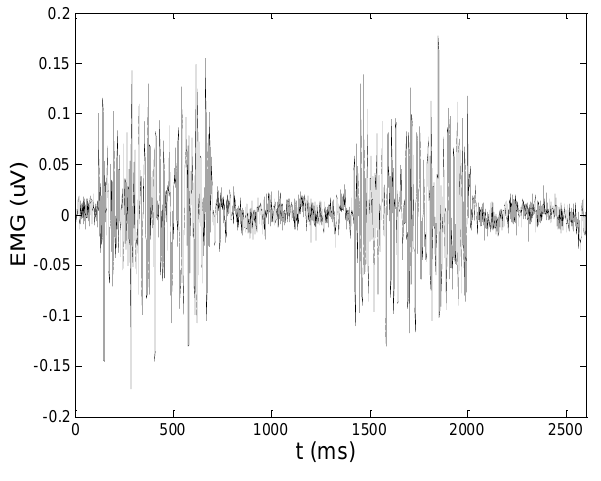
Figure 9. Simulated artificial EMG signal with added noises.